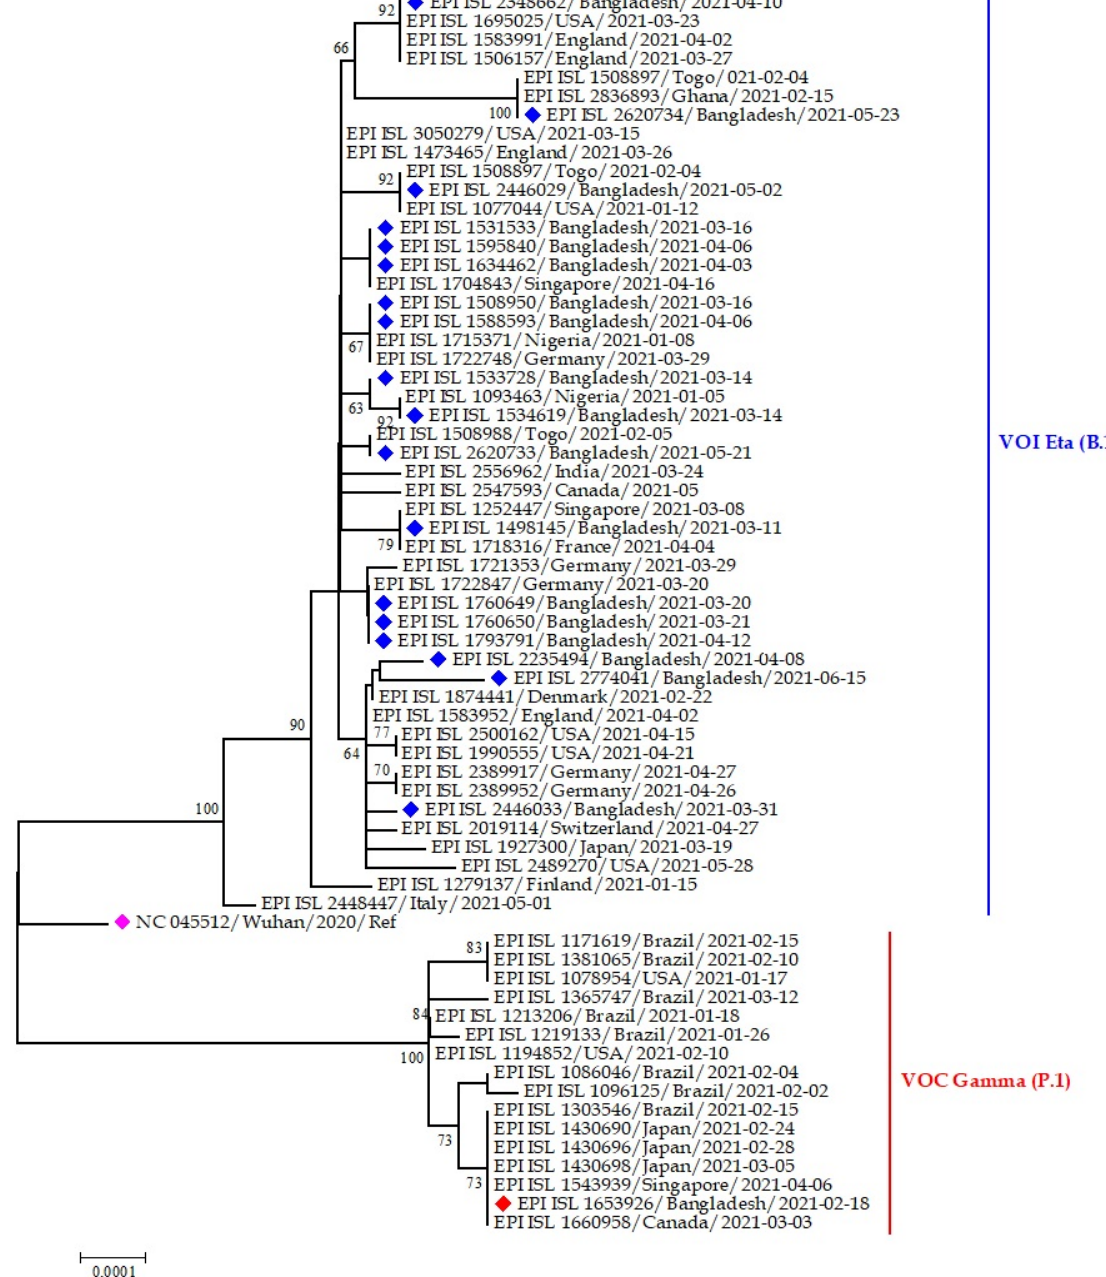
Figure 11. Phylogenetic analysis of emerging Eta and Gamma variants of SARS-CoV-2 Bangladeshi isolates. Here, blue dots denote Eta variant SARS-CoV-2 viruses; red and pink dotes denote Gamma variant and Wuhan-Hu-1 viruses, respectively.